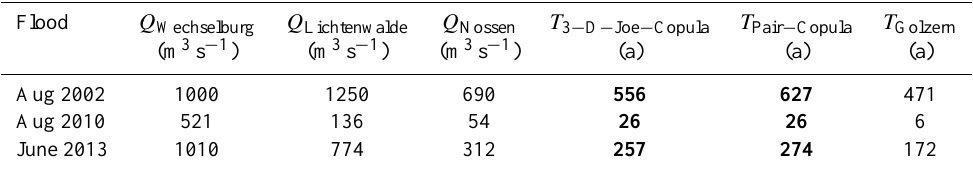
Table 2. Return periods based on trivariate Joe-Copula and Pair-Copula for the simultaneous peak discharges at the sites Wechselburg, Lichtenwalde und Nossen for selected flood events; the last column shows the univariate return periods at the gauging station Golzern based on the official flood statistics. The results of the multivariate model are highlighted in bold font.